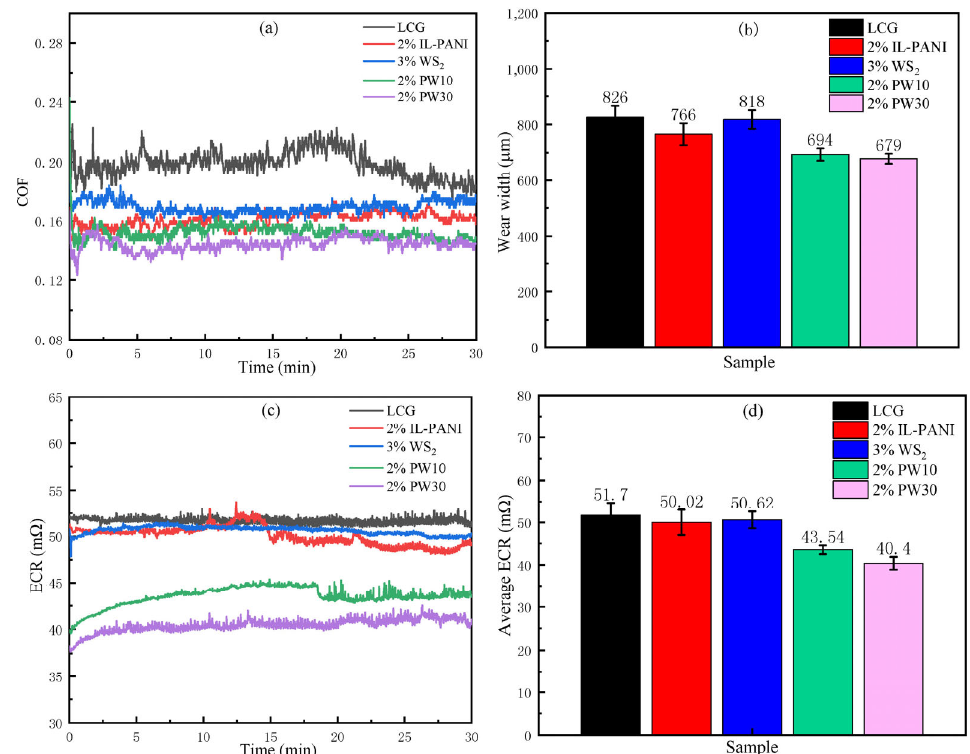
Fig. 7 (a) COFs, (b) wear widths, (c) ECRs, and (d) average ECRs of greases with optimal additive concentrations on copper–copper friction pair (voltage: 1.5 V; load: 15 N; frequency: 2 Hz; stroke: 5